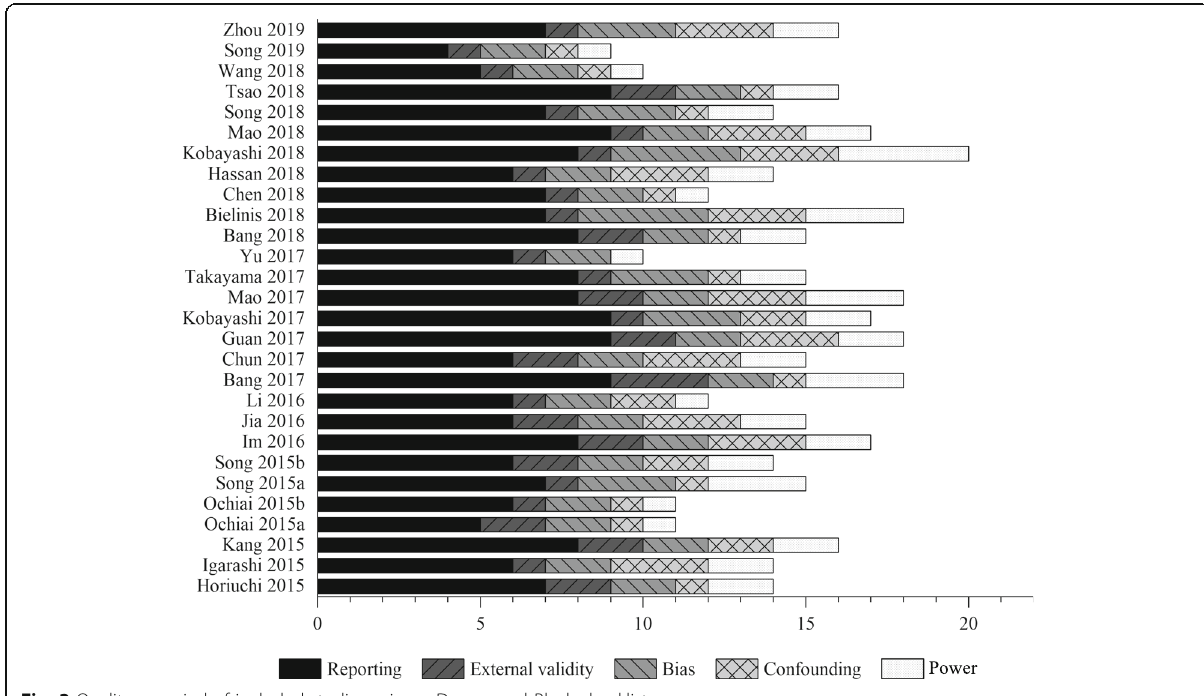
Fig. 3 Quality appraisal of included studies using a Downs and Black checklist